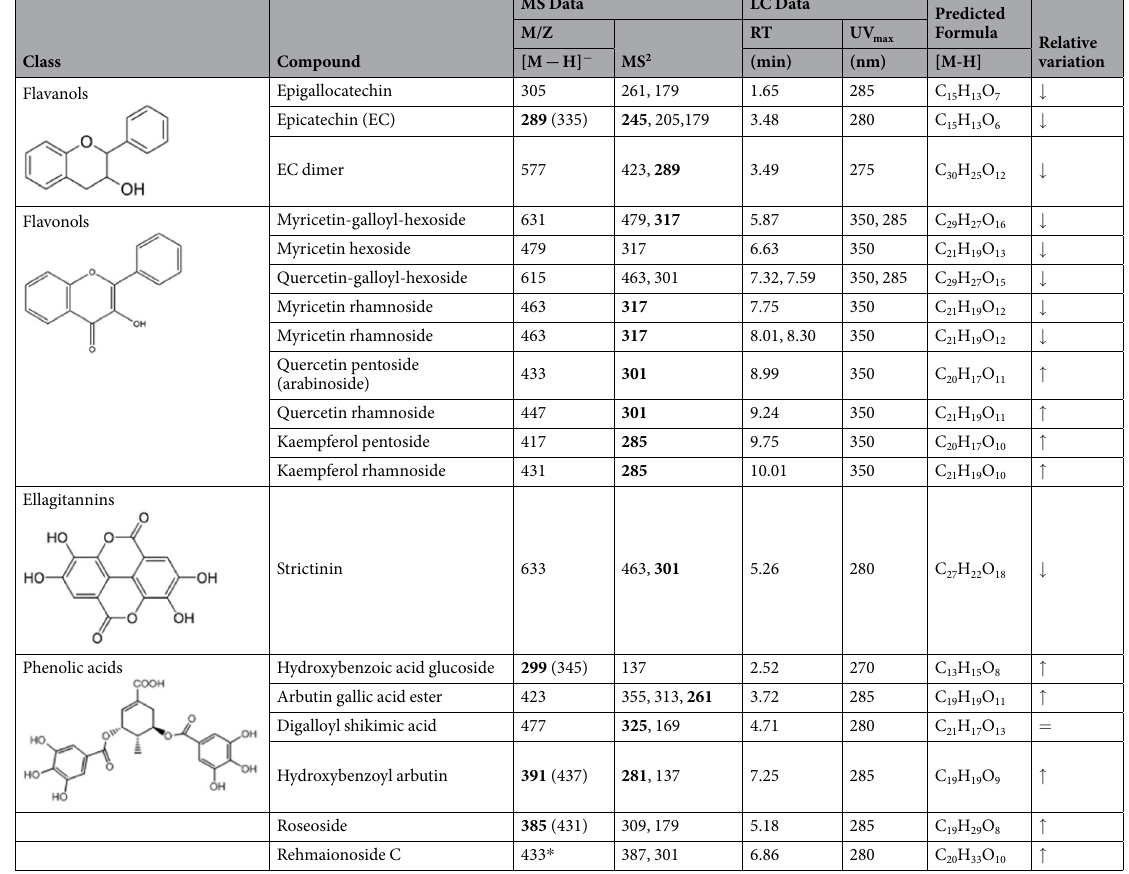
Table 1. (Poly)phenol metabolites present in A . unedo leaf before (original) and after in vitro digestion (LPDMs). (Poly)phenol putative identifications, structure and classes are presented, as well as MS (m/z and MS2) and LC (retention time and PDA) data. The m/z values in bold are the major ions or fragments. Values in brackets are formic acid adducts. All components were noted in the original extract and their fate in the digest sample is noted in the last column (LPDMs vs . Original). The formulae were predicted from exact mass data with ppm of < 2 ppm in all cases. * This is tentatively identified as the formic acid adduct of m/z 387, and